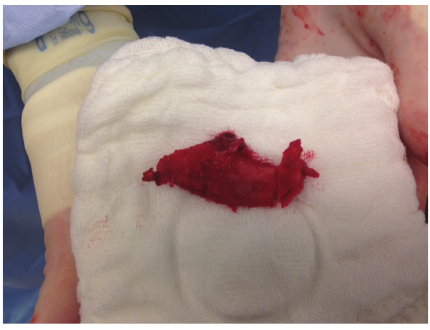
Figure 6: First rib